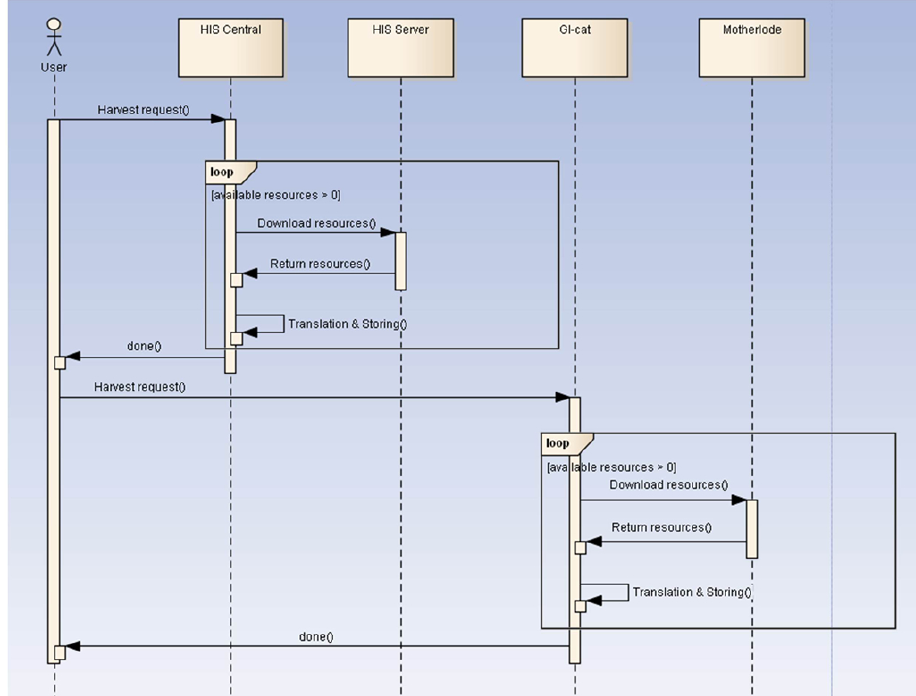
Fig. 16. Sequence diagram showing the harvesting of data services to the catalogs.